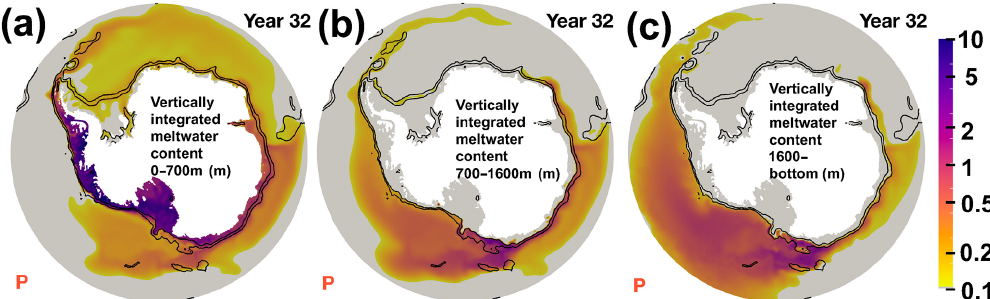
Figure 6. January mean vertically integrated glacial meltwater content between (a) 0 and 700m, (b) 700 and 1600m, and (c) 1600m and bottom of year 32 for PRS case (P). The bathymetry contours of 1000 and 2500m are shown with black lines. Values lower than 0.1 are indicated with gray.